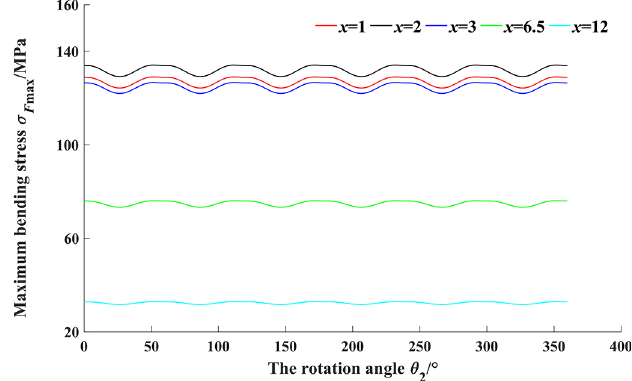
Fig. 10. Tooth root bending stress of different